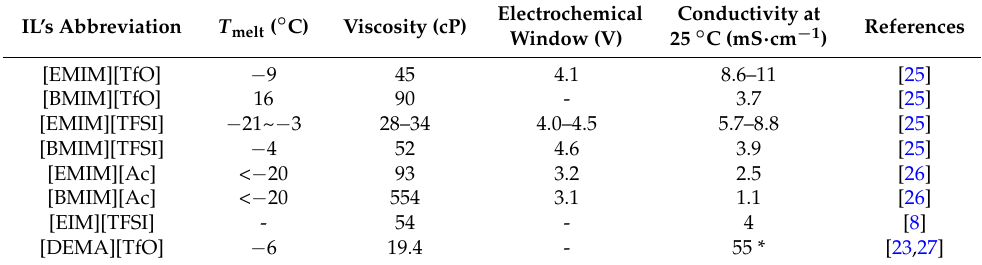
Table 1. Physicochemical properties of ILs used in this study. [EMIM][TfO]: 1-ethyl-3-methylimidazolium trifluoromethanesulfonate; [BMIM][TfO]: 1-butyl-3-methylimidazolium